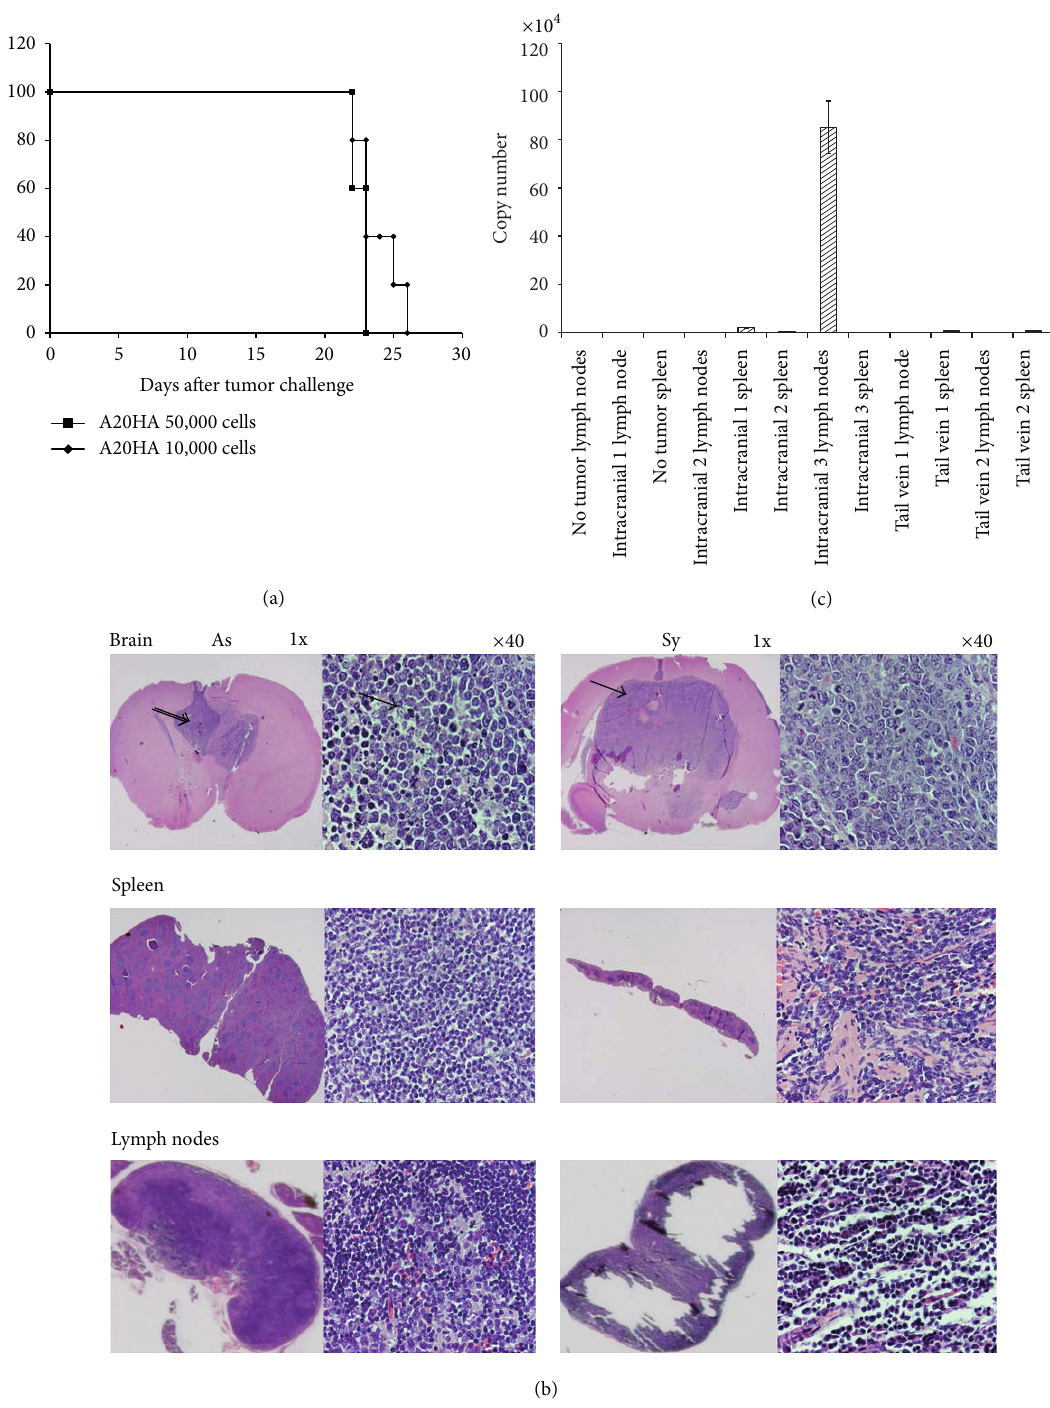
Figure 1: A20HA brain tumor growth in syngeneic BALB/c mice leads to fast death of mice and fatal depletion of spleens and lymph nodes in symptomatic mice. (a) Kaplan-Meier survival curve showing growth rates of A20HA B-cell lymphoma in brain after i.c. injection of 10,000 and 50,000 tumor cells ( 𝑛 = 5 in each group). A representative experiment among the three is shown. (b) Photomicrographs of eosin and hematoxylin stained coronal sections of the brains, spleens, and lymph nodes from (a) on day 21 after A20HA i.c. inoculation showing the forming of brain tumors (showed by arrows) and depletion of spleens and lymph nodes in asymptomatic (As) and symptomatic (Sy) mice that received 10,000 and 50,000 tumor cells, correspondingly. Magnifications × 1 and × 40. (c) RT-PCR of spleens and lymph nodes showing minor metastases of A20HA cells in lymph nodes on day 14 after i.c. A20HA injection (50,000 cells). Three individual mice in each group were analyzed. 𝑃 < 0.05